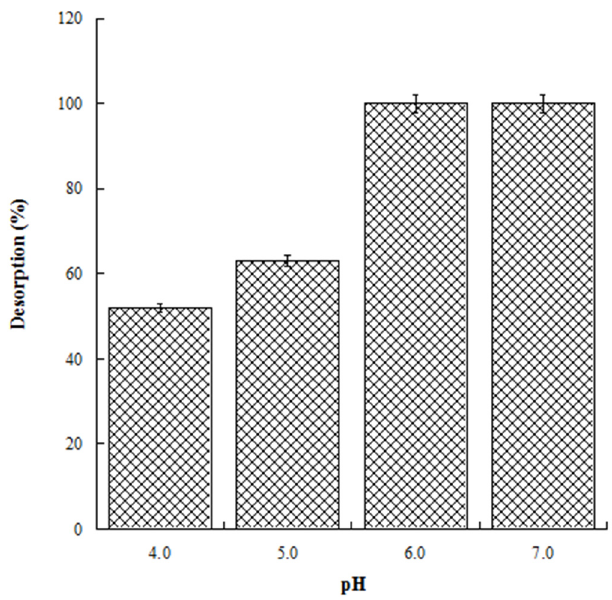
Figure 4. Release of GA from HL-3D chitosan-GA complexes at pH 4.0, 5.0, 6.0 and 7.0 after 24 h of incubation time.